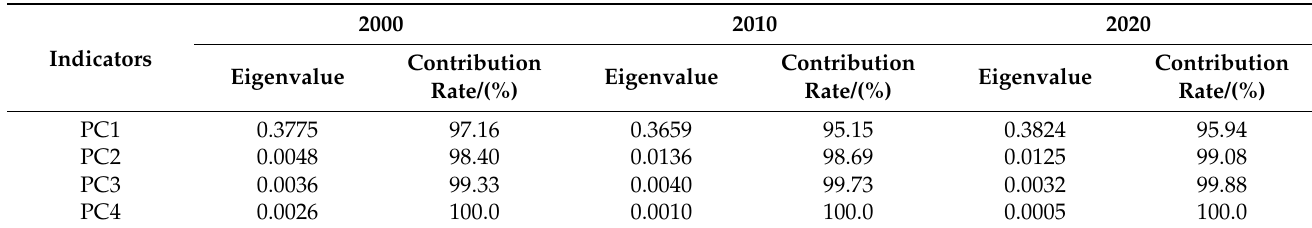
Table 4. Eigenvalues and contribution rates of the four indicators in PCA analysis.